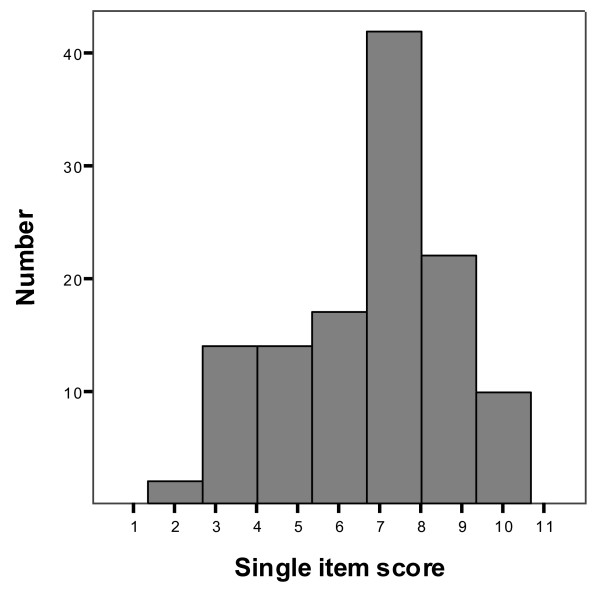
The distribution of the single-item score for 121 adult cystic fibrosis patients.